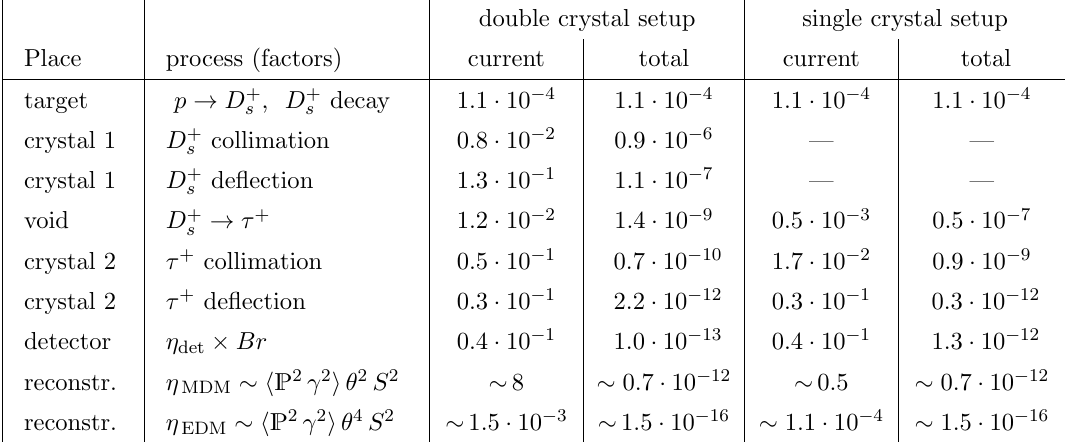
Table 2 . E(cid:14)ciency of the measurement: current (by process) and total (per incident